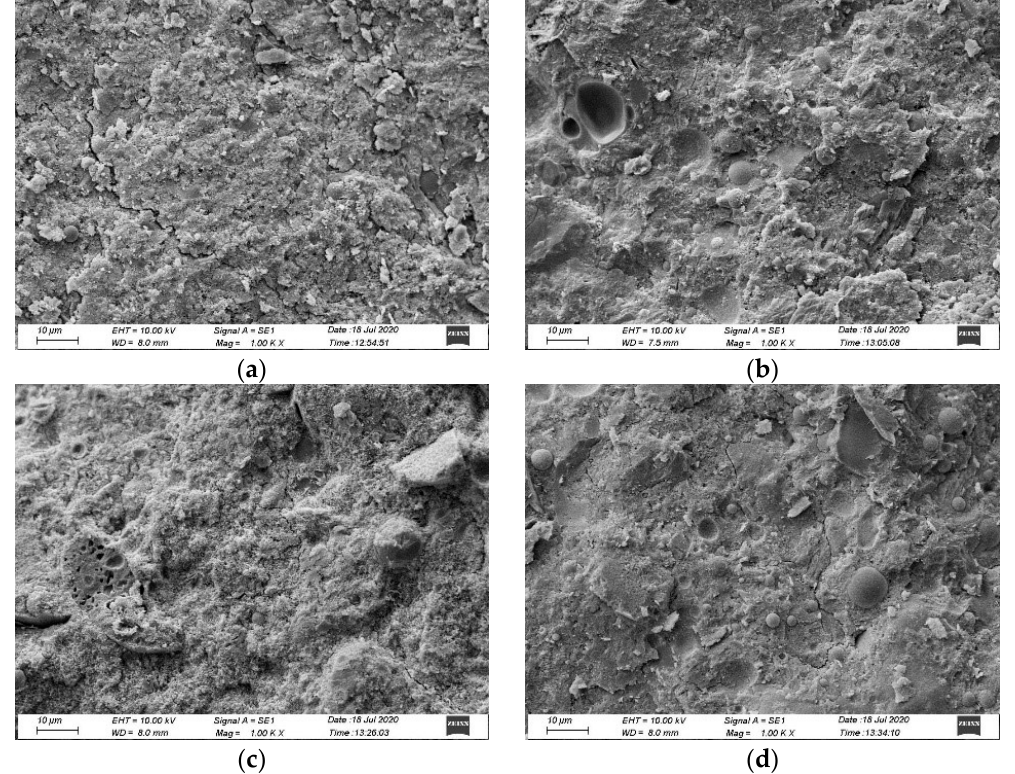
Figure 12. SEM image of specimens with RBCA after 3%NS-45FT (1000 × ). ( a ) R100-FA15, ( b ) R100-FA30, ( c ) R80-FA15, ( d ) R80-FA30. Note: R is for recycled brick-concrete aggregate; FA is for fly ash; numbers are the value of replacement rate (%).